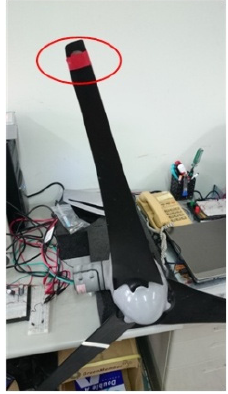
Figure 24. A block attached near the tip of a blade.